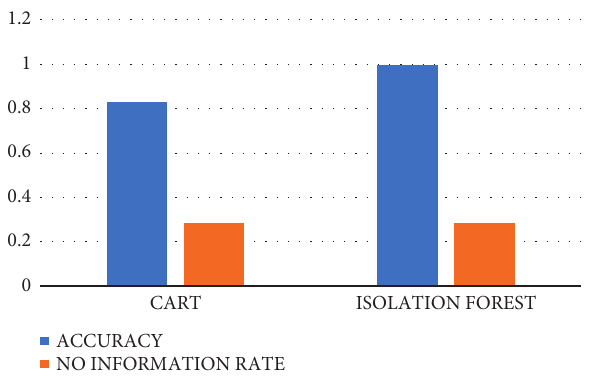
Figure 8: Comparison of data mining